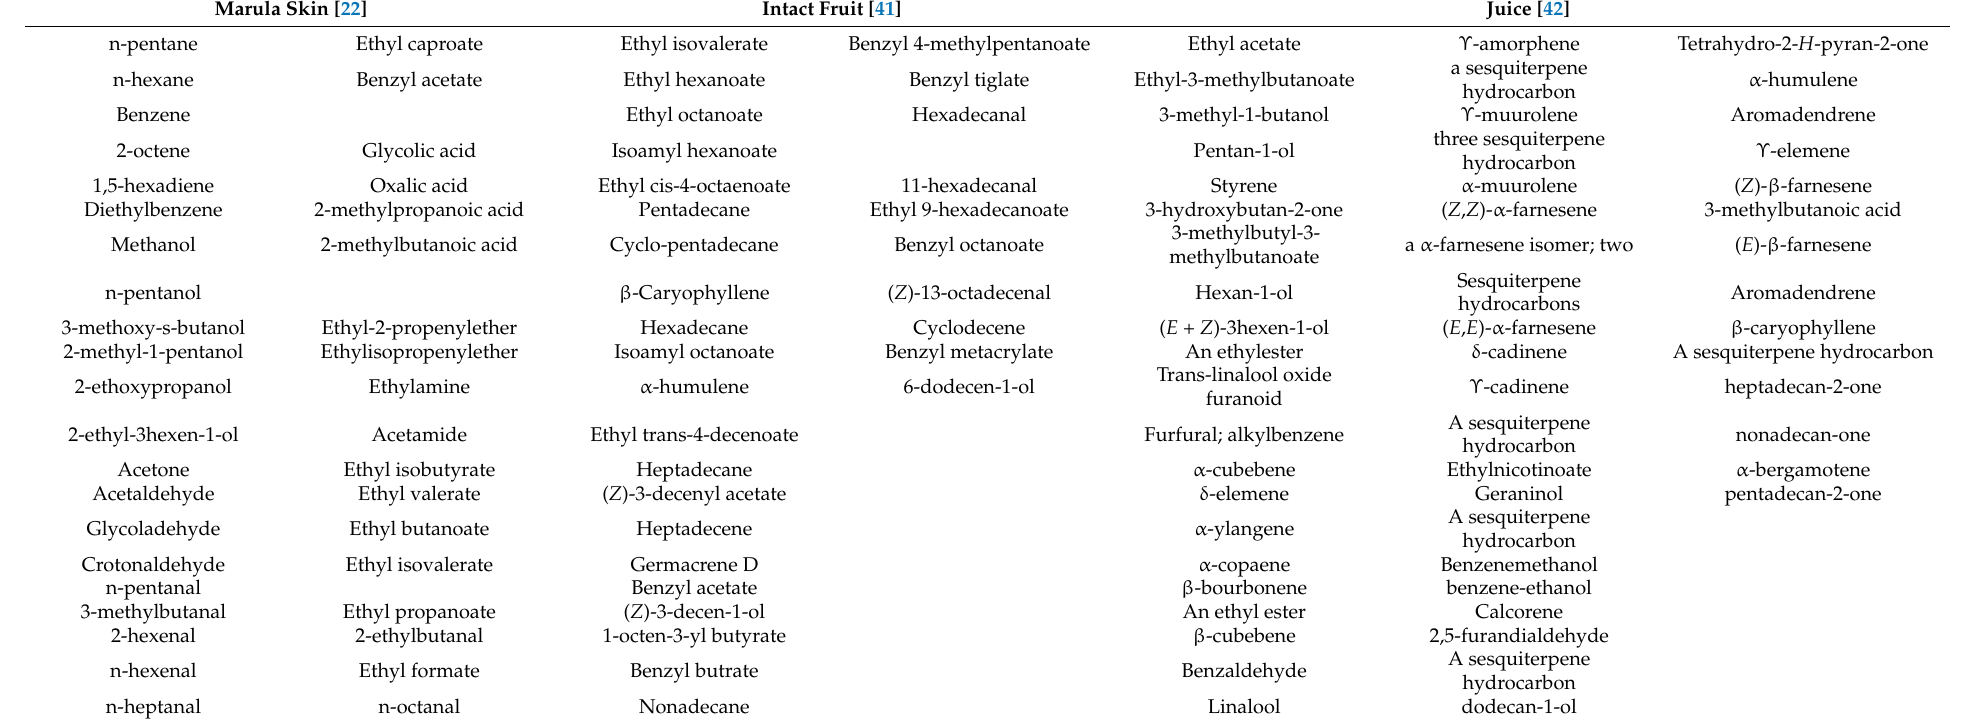
Table 3. Different volatile compounds extracted from intact marula fruit, skin and